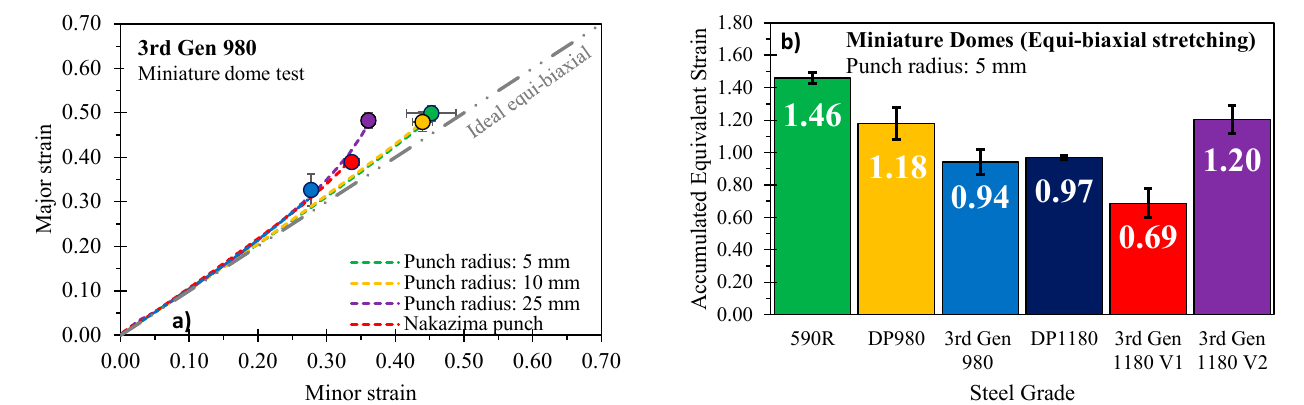
Figure 27. The effect of punch size on the linearity of strain path and the failure strain representatively shown for the 3rd Gen 980 ( a ) and integrated failure strains under equi-biaxial stretching ( b ). Note that the data for the DP980 was retrieved from Cheong [56] and the DP1180 from the Numisheet 2022 Benchmark [16] using the same test frame.